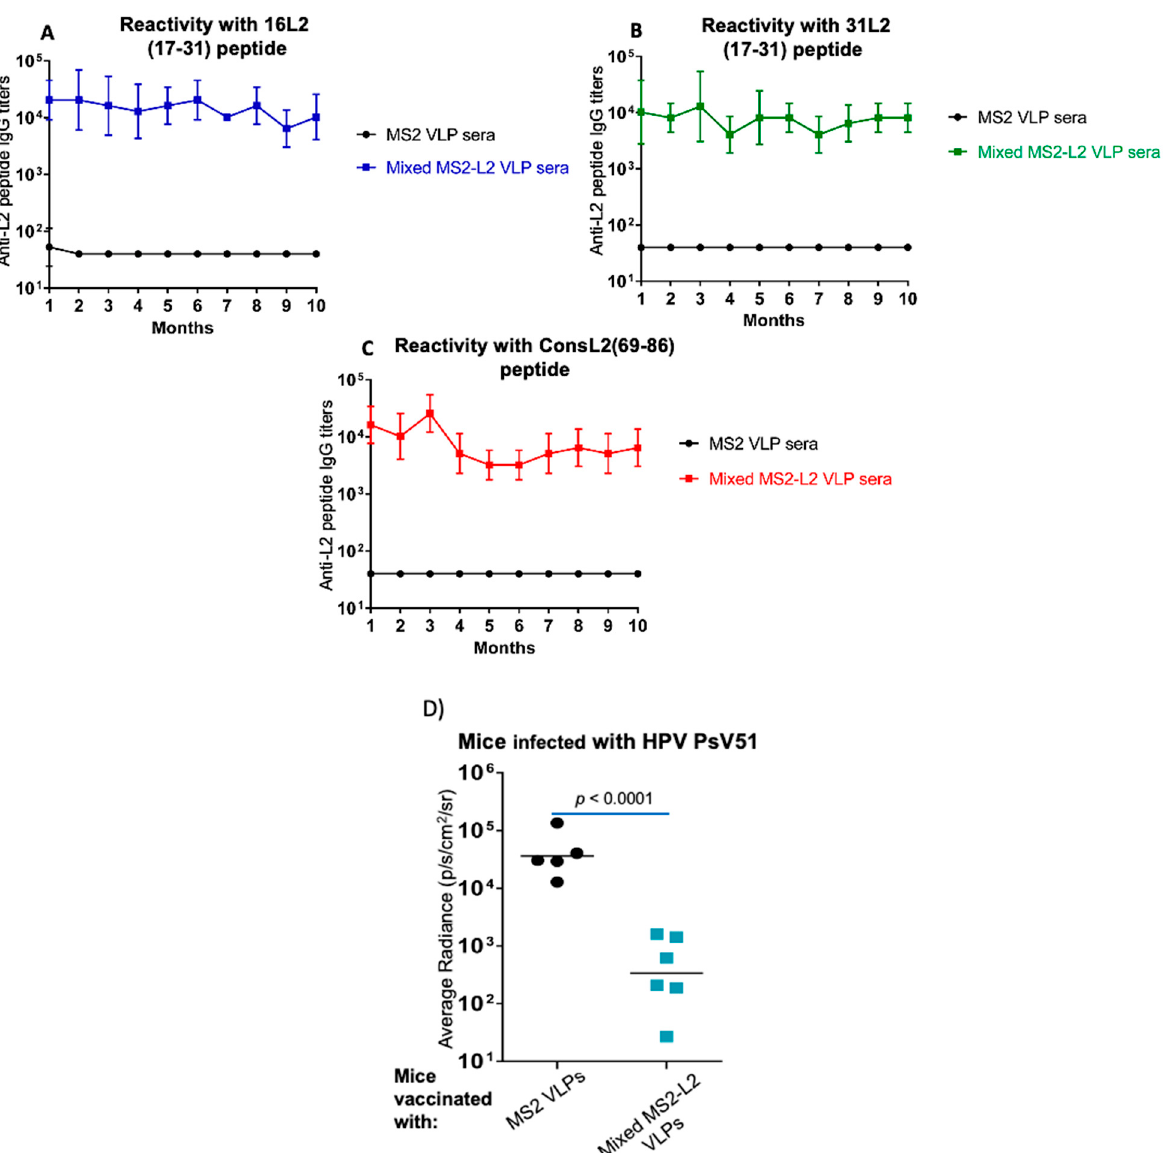
Figure 5. Longevity of mixed MS2-L2 VLP antibodies. Mice were immunized, thrice, intramuscularly with 10 μ g (each) of mixed MS2-L2 VLPs with alum at two-week intervals. Sera were collected monthly (for 10 months) after the last immunization. Anti-L2 peptide IgG titers in sera were determined by end-point dilution ELISA using the following peptides as target antigens: ( A ) HPV16 L2, ( B ) HPV31 L2, and ( C ) HPV consL2 (69-86). ( D ) Immunized mice were challenged after 10 months with 6.4 × 10 6 infectious units of HPV PsV51. Each datum represents the average radiance of an individual mouse, and the lines represent the geometric mean for each group of mice. The p -value was determined by an unpaired one-tailed t -test for Figure 5D.